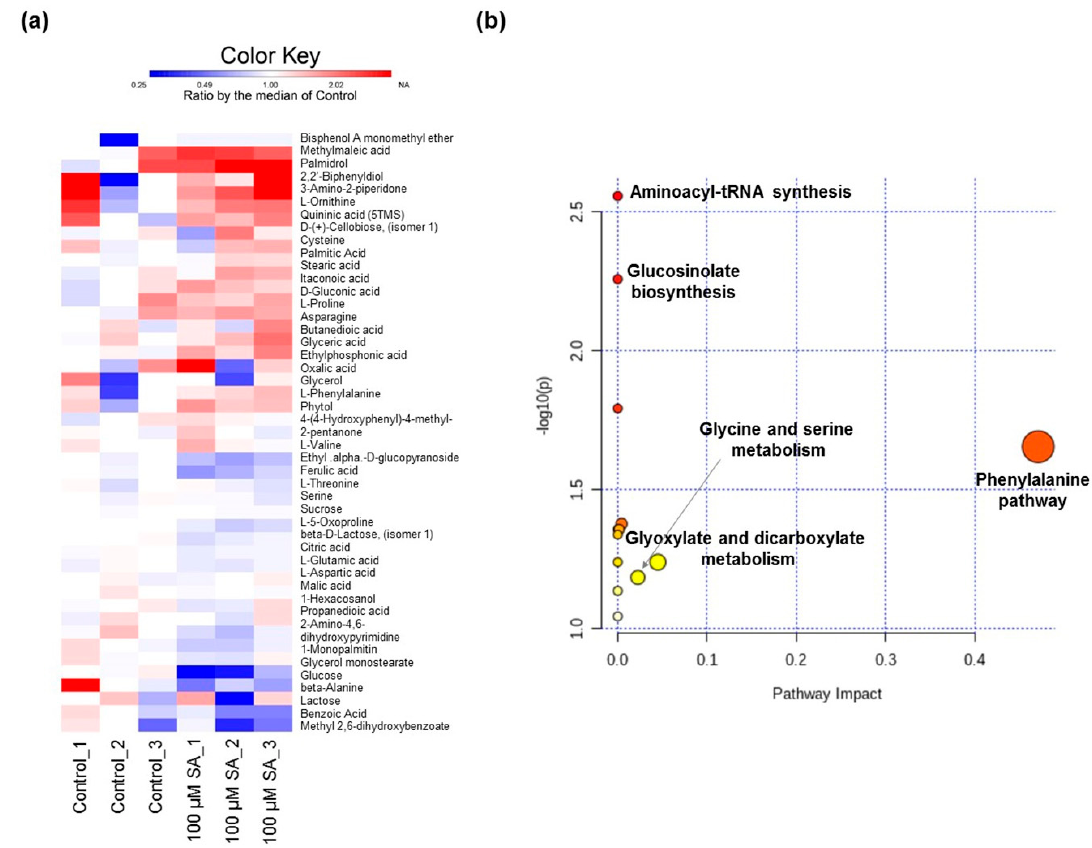
Figure 6. Metabolomics analysis of detached Keumkang wheat leaves treated with SA. ( a ) Heatmap and ( b ) pathway analyses of metabolites identified from the detached Keumkang wheat leaves of 14-days-old seedlings grown on the BAP media containing SA or vehicle ethanol (control) for 7 days after inoculation with leaf rust using a detached leaf assay. In ( a ), the color range is from red to blue, representing from high to low expression, respectively. In ( b ), the pathway impact is represented alternatively as the score in the x-axis or circle size, and the − log10( p ) value is represented alternatively as the number of scores in the y-axis or color. The color range is from red to yellow, representing from high to low − log10( p ) value, respectively.